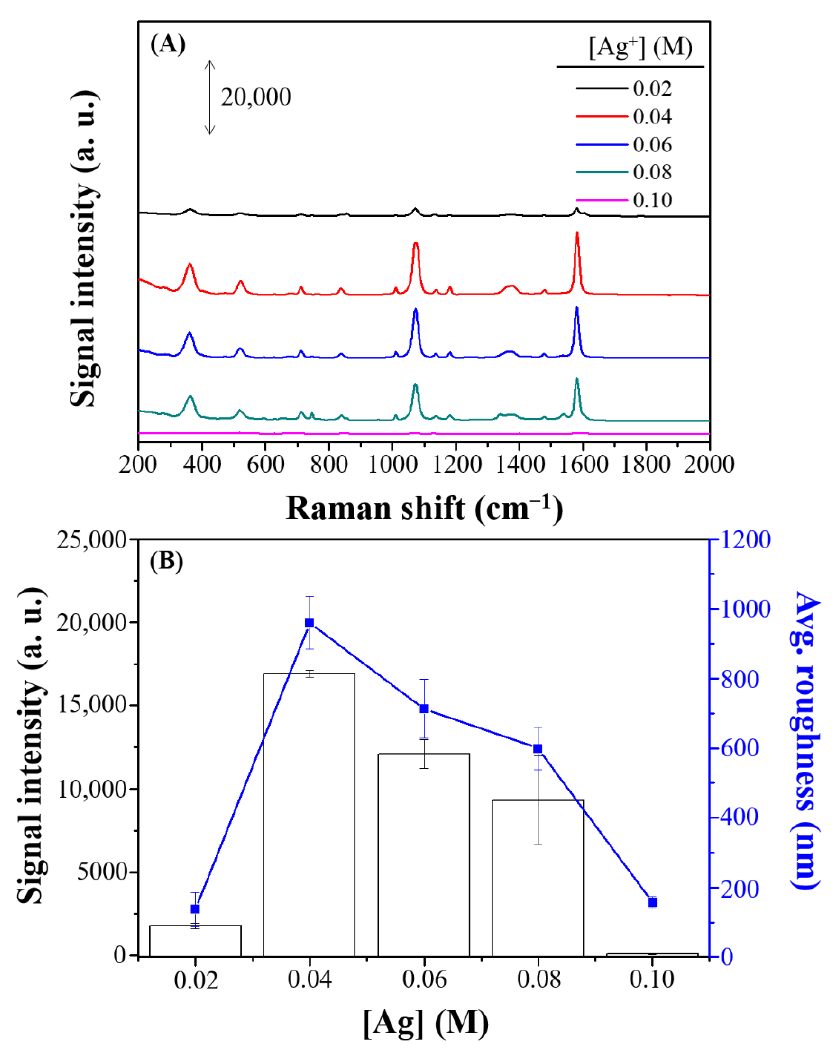
Figure 3. ( A ) SERS spectra and ( B ) Raman intensity and average roughness (nm) of 100 µM 4-MBA on Ag nanostructures prepared with various concentrations of Ag + ions (0.02, 0.04, 0.06, 0.08, and 0.10 M). The error bars represent the standard deviations by using three batches of Ag substrates for which the average signal of 10 spots per sample are recorded.